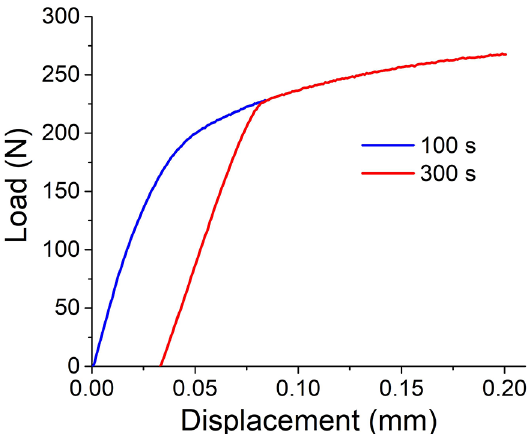
Figure 2. Load vs. Displacement curves obtained from both deformation